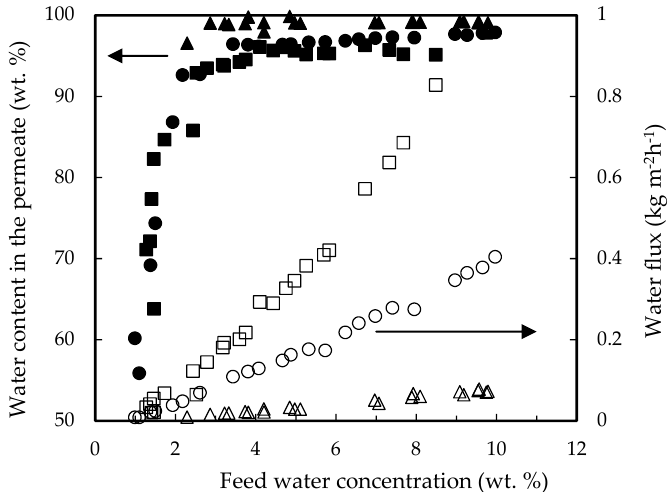
Figure 1. Water permeation fluxes (open symbols) and water concentration in permeate (filled sym ‐ bols) as a function of feed water content for the three PV membranes tested. ( , ) PERVAP TM 3100, ( , ) PERVAP TM 1131 and ( , ) PERVAP TM 2216. Initial feed content: 13.5% lactic acid, 17.7% ethyl lactate, 10% water and 58.8% ethanol. Temperature = 60 °C.